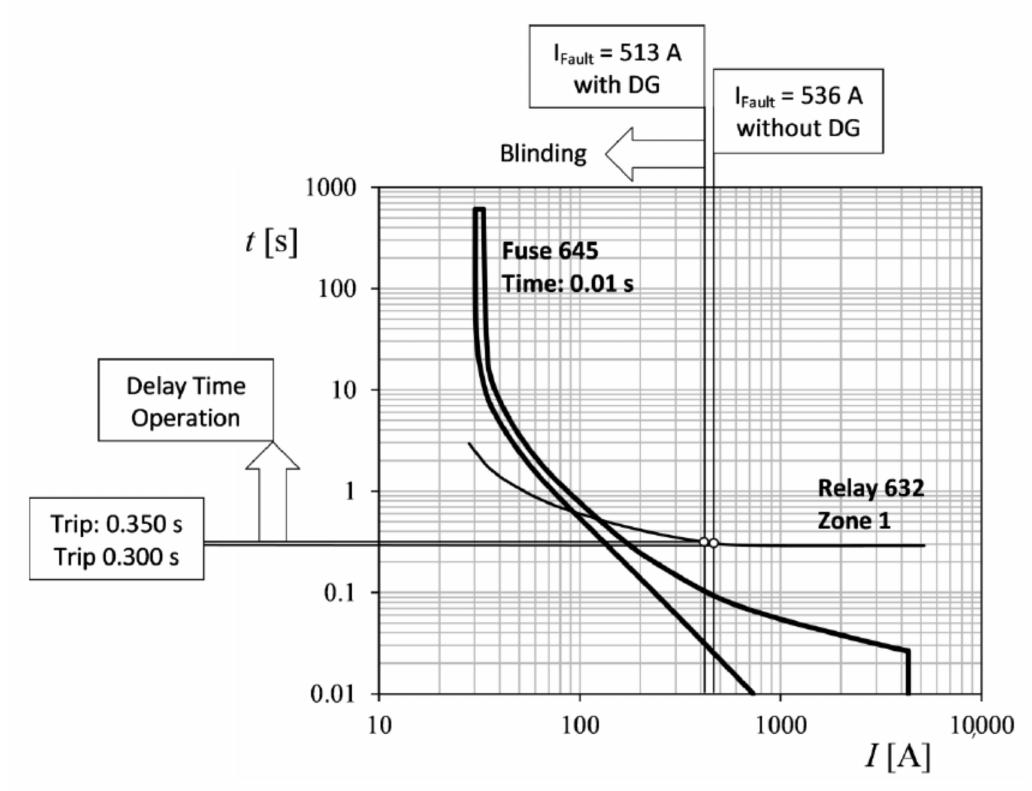
Figure 4. Protection Zone 1 current-time ( I-t ) performance in case of a three-phase short-circuit with 25% DG power (1 MW) at bus 645 (see Figure